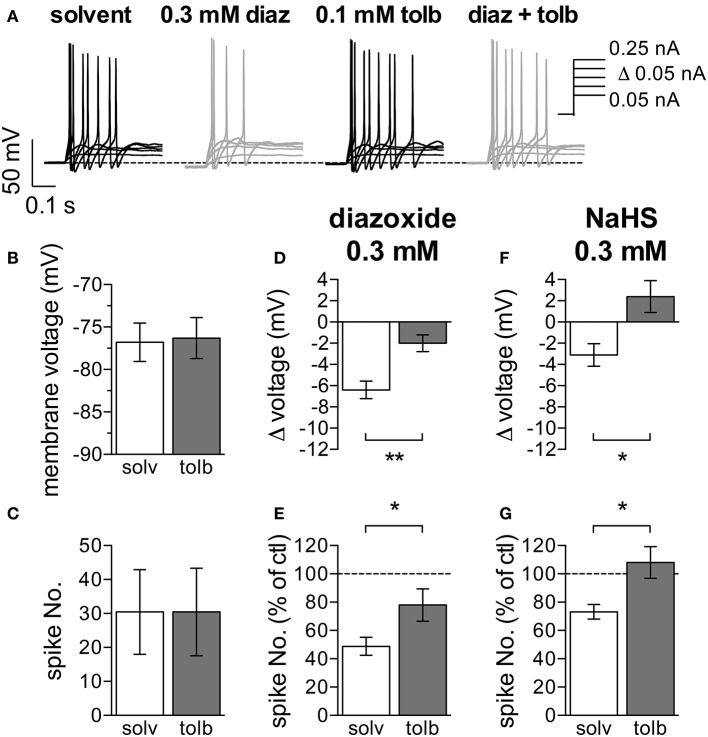
Effects of KATP channel modulators on membrane potential and action potential firing in SCG neurons. The membrane potential was recorded in the perforated current-clamp mode. Currents with increasing amplitudes (50 to 250 pA as indicated in A) were injected for 1 s periods, once every 12 s. The membrane potential was evaluated during the 1 s interval before current injection. Baseline values were recorded in presence of solvent (0.5% DMSO–0.5% NaOH), followed by a 300 s application of either diazoxide (0.3 mM, diaz) or NaHS (0.3 mM). These two agents were applied in solutions containing solvent and tolbutamide (0.1 mM, tolb), respectively, which were also present for 120 s prior to the inclusion of diazoxide or NaHS. Panel (A) shows representative traces recorded in the presence of solvent, diazoxide, tolbutamide, and diazoxide plus tolbutamide, respetively. Panels (B,C) show the effects of tolbutamide on (B) the membrane potential and (C) action potential firing (n = 11). (D) Changes in membrane voltage induced by 0.3 mM diazoxide in the presence of solvent (n = 10) and tolbutamide (n = 10), respectively. (E) Changes in the number of action potentials triggered by current injections due to the application of 0.3 mM diazoxide in either solvent (n = 10) or tolbutamide (n = 10). The number of spikes in the presence of diazoxide is shown as percentage of the number of spikes in in its absence. (F) Changes in membrane voltage induced by 0.3 mM NaHS in the presence of solvent (n = 6) and tolbutamide (n = 7), respectively. (G) Changes in the number of action potentials triggered by current injections due to the application of 0.3 mM NaHS in either solvent (n = 6) or tolbutamide (n = 7). The number of spikes in the presence of NaHS is shown as percentage of the number of spikes in in its absence. * and ** Indicate significant differences between the values obtained in solvent and tolbutamide at p < 0.05 and p < 0.01, respectively (Mann-Whitney test).